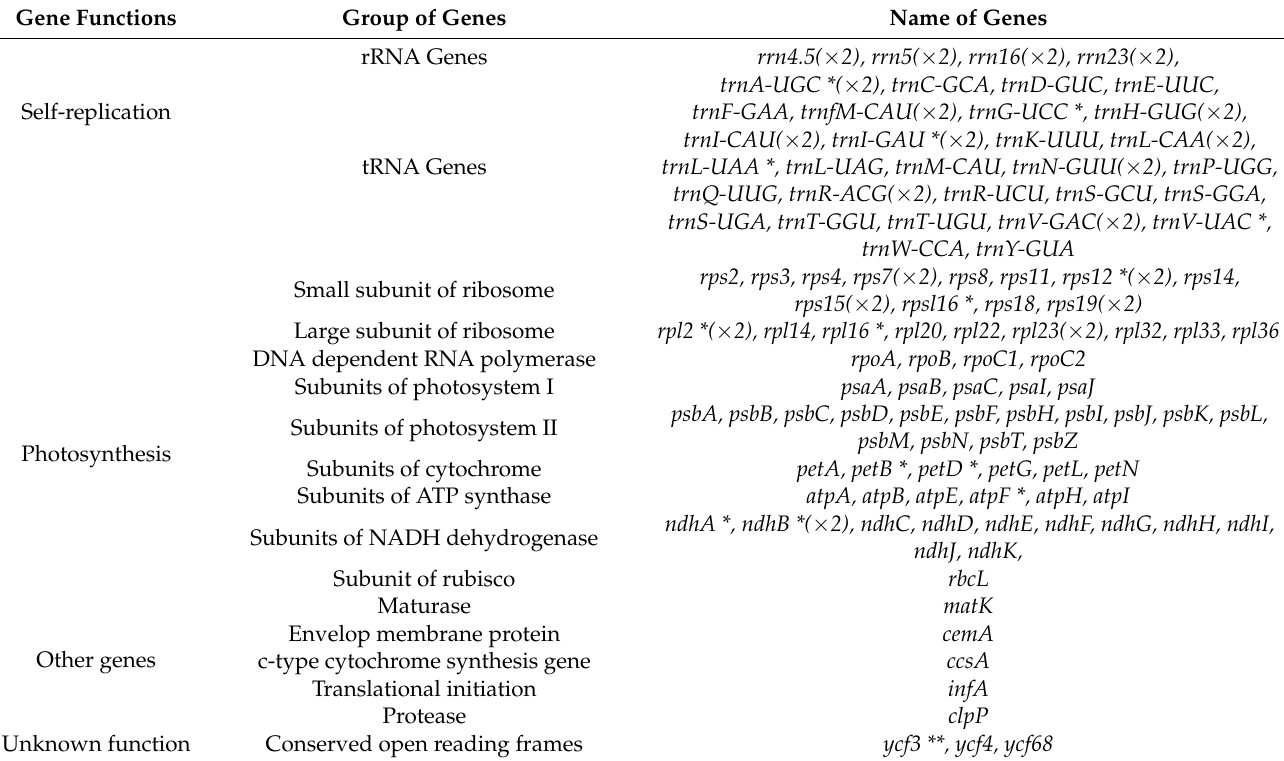
Table 1. Annotated list of genes identified within the cp genome of Indosasa lipoensis .